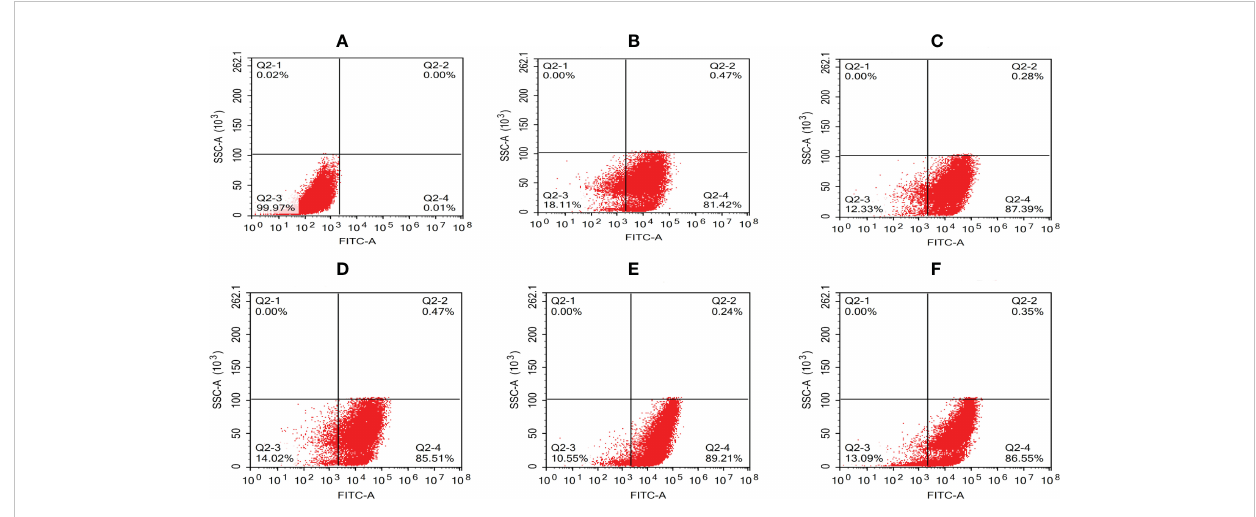
FIGURE 4 Quantative analysis of macrophages infected with N. seriolae by fl ow cytometry. (A) Uninfected cells: (B) 2 hpi, (C) 4 hpi, (D) 6 hpi, (E) 8 hpi, and (F) 12